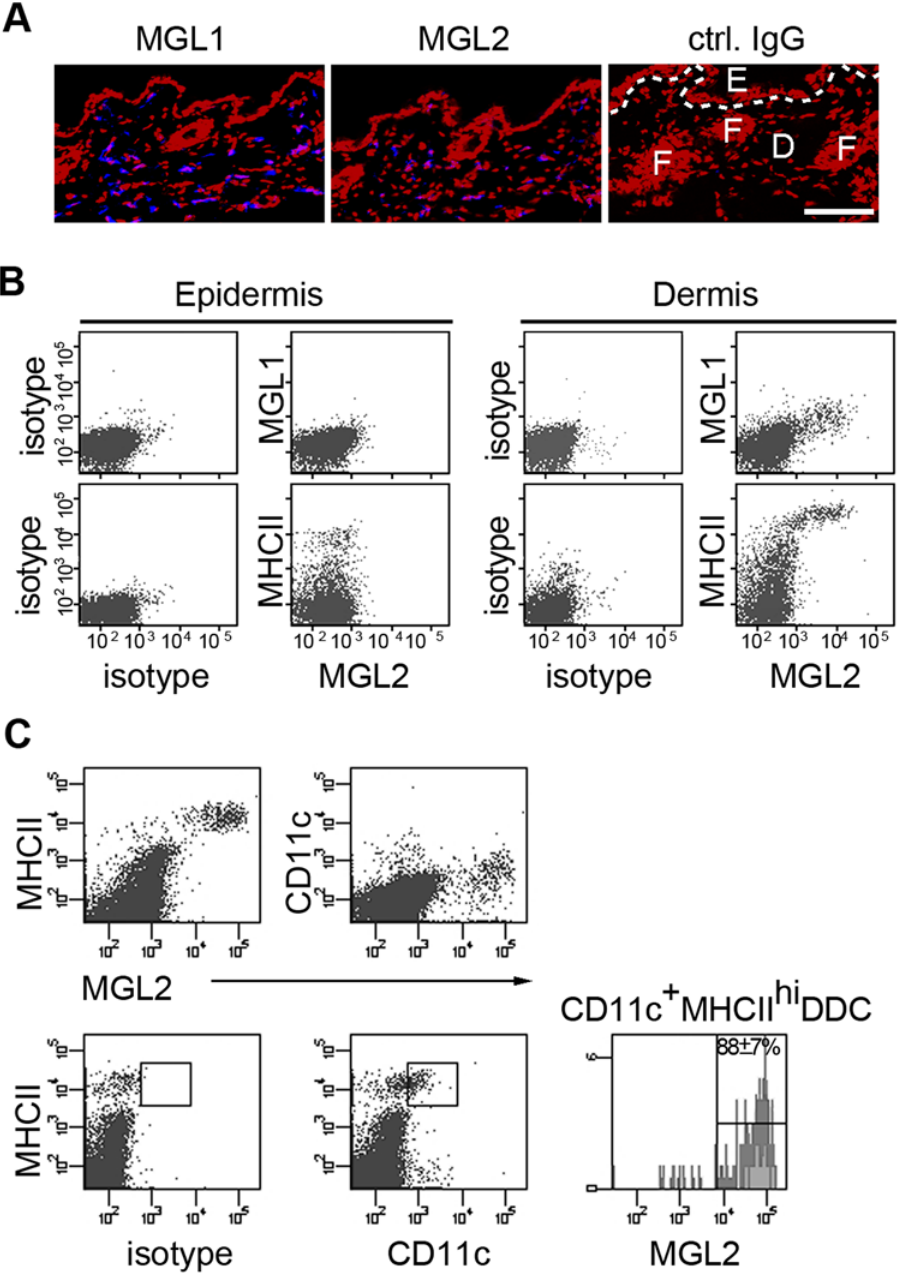
Figure 1. Expression of MGL1 and MGL2 in a DDC subset in skins of naive mice. (A) Binding of anti-MGL1 and anti-MGL2 mAbs to cryosections of skin (blue in each panel). The dashed line in the control panel (Ctrl. IgG) indicates the dermal-epidermal junction. Nuclei are shown in red. Scale bar, 100 m m. E: epidermis, D: dermis, F: hair follicle. (B) Surface staining by anti-MGL1 and anti-MGL2 mAbs of epidermal and dermal cell suspensions. (C) Intracellular staining of CD11c and surface staining of MHCII and MGL2 in the dermal cell suspension. Virtually all MGL2 + cells expressed CD11c. The proportion of MGL2 + cells in MHCII hi CD11c + DDC (cells in the rectangular gate) was 88.5 6 6.8%.